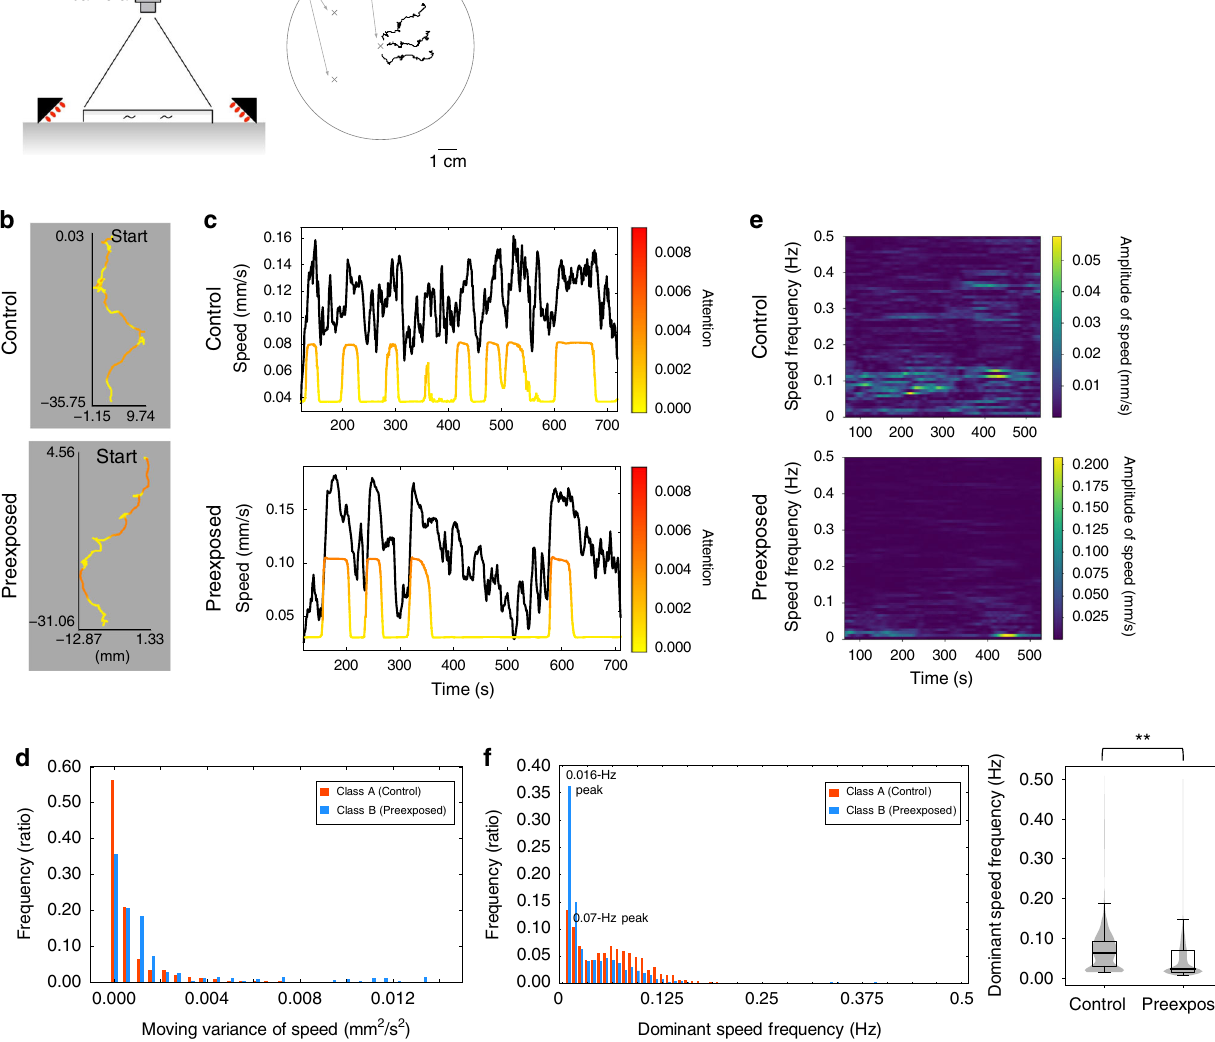
Fig. 3 DeepHL analysis of repulsive odor learning in worms. a The experimental setup (left) for monitoring the worm ’ s trajectory (right). b Example trajectories of worms colored by attentions of a discriminator layer. Segments of the trajectories corresponding to the run state of the worm are highlighted (in red). c Time series of the moving average of speed (black lines) associated with attention values (colored lines). The upper and lower graphs are obtained from the upper and lower trajectories shown in b , respectively. d Histograms showing the distributions of the moving variance of speed for each time slice within the highlighted trajectory segments. e Frequency analysis of the velocity of a preexposed or control worm. A 128-s-wide sliding window was shifted in 1-sample intervals and the amplitude of each frequency component was obtained from its fast Fourier transform (FFT). The upper and lower spectrograms were, respectively, obtained from the upper and lower trajectories shown in b . f Frequency analysis of the velocity of all the preexposed or control worms computed from entire trajectories. The histograms and box plot show the distributions of the dominant frequency of speed for each time slice. The dominant frequency is the one with the largest amplitude within each window. Signi fi cant difference in the dominant frequencies were observed by a generalized linear mixed model (GLMM) with Gaussian distributions ( t = − 6.60; d.f. = 322.8; p = 1.68 × 10 − 10 , effect size( r 2 ) = 0.232; ** p < 0.01; see “ Methods ” ). The p value is two sided. The box plot shows the 25 – 75% quartile, with embedded bar representing the median; lower whiskers show Q1 − 1.5 × IQR (Q1: 25% quartile; IQR: interquartile range); upper whiskers show Q3 + 1.5 × IQR (Q3: 75% quartile). Control: n = 76, 784, preexposed: n = 75,